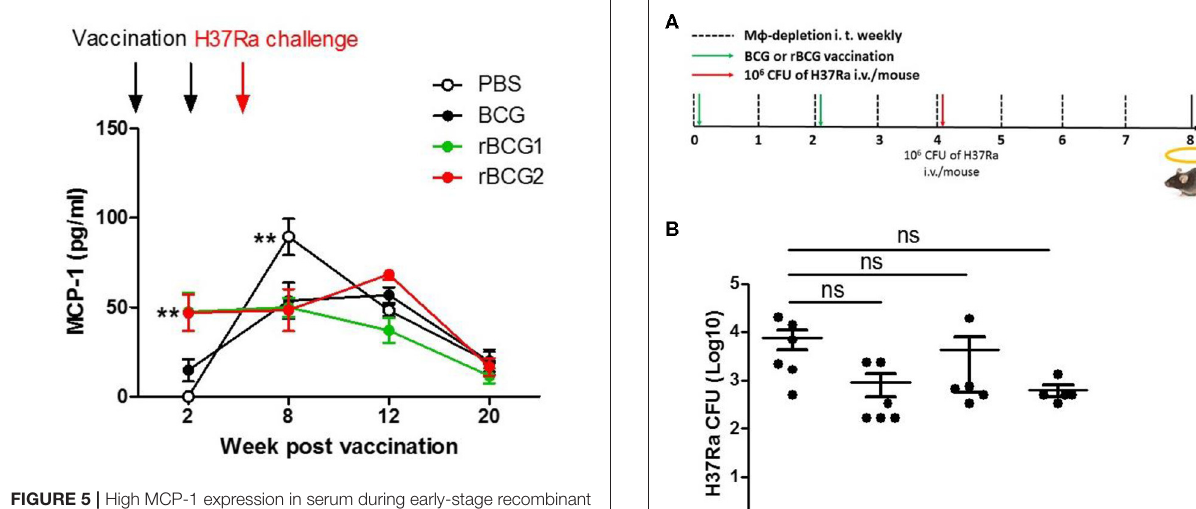
FIGURE 5 | High MCP-1 expression in serum during early-stage recombinant BCG vaccination. C57BL/6 mice were immunized with BCG, rBCG1, and rBCG2 at weeks 0 and 2, and then challenged with H37Ra at week 4 ( n = 6–7, in two independent experiments). At 2, 8, 12, and 20 weeks, sera were collected, diluted 20,000 times, and assayed using a multiple cytokine kit. Differences among groups were determined by two-way ANOVA with a Bonferroni post hoc test (** P < 0.01).